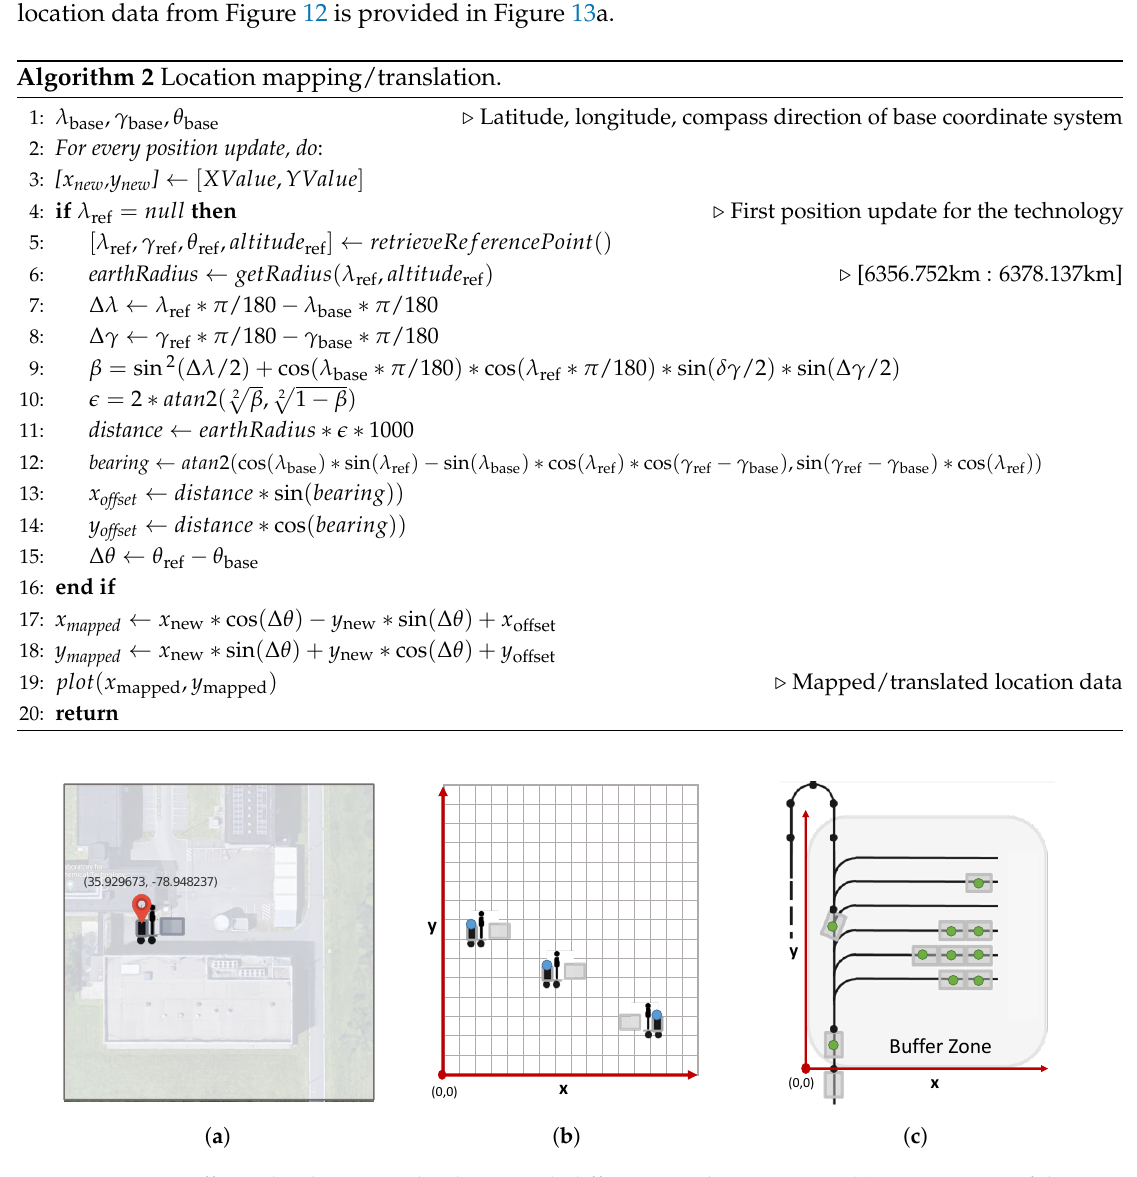
Figure 12. Different localization technologies with different coordinate systems ( a ) GPS position of the operator; ( b ) Indoor Localization 1; ( c ) Indoor Localization